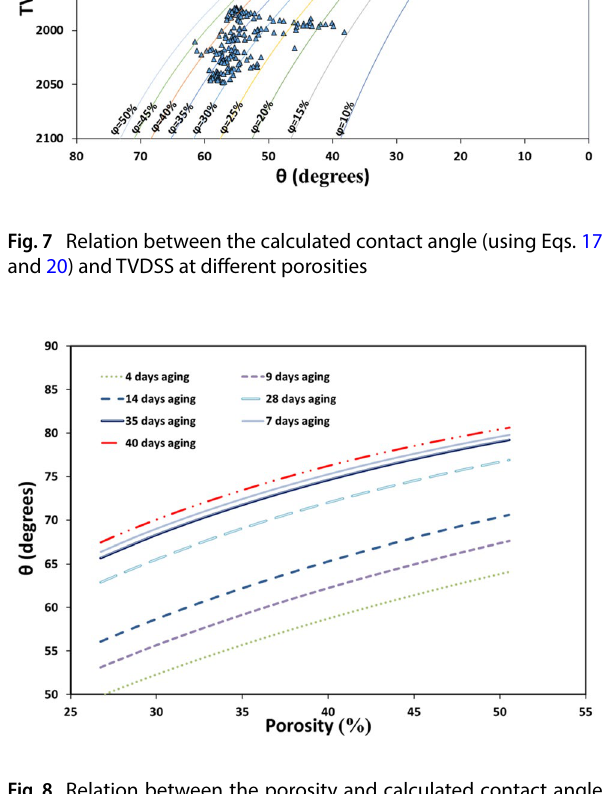
Fig. 8 Relation between the porosity and calculated contact angle at a displacement temperature of 45 ºC for Rørdal samples